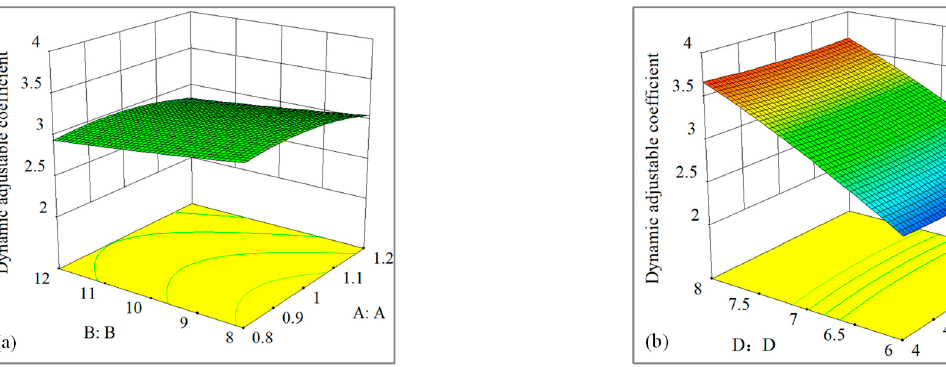
Figure 17. Relationship between adjustable damping coefficient and design variables: ( a ) adjustable damping coefficient λ vs. A and B; and ( b ) adjustable damping coefficient λ vs. C and D.